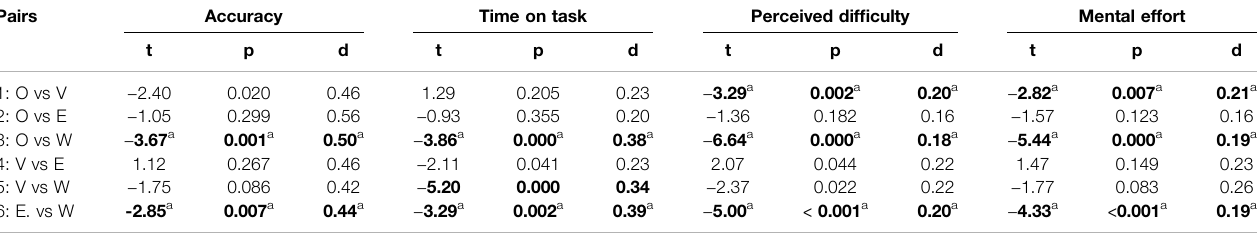
TABLE 4 | Statistics of the Paired t-tests Comparing Differences in Accuracy, Time on Task, Perceived Dif fi culty and Mental Effort Between Complex and Simple Problems Across the Four Types of Rating Scales. Pairs Accuracy Time on task Perceived dif fi culty